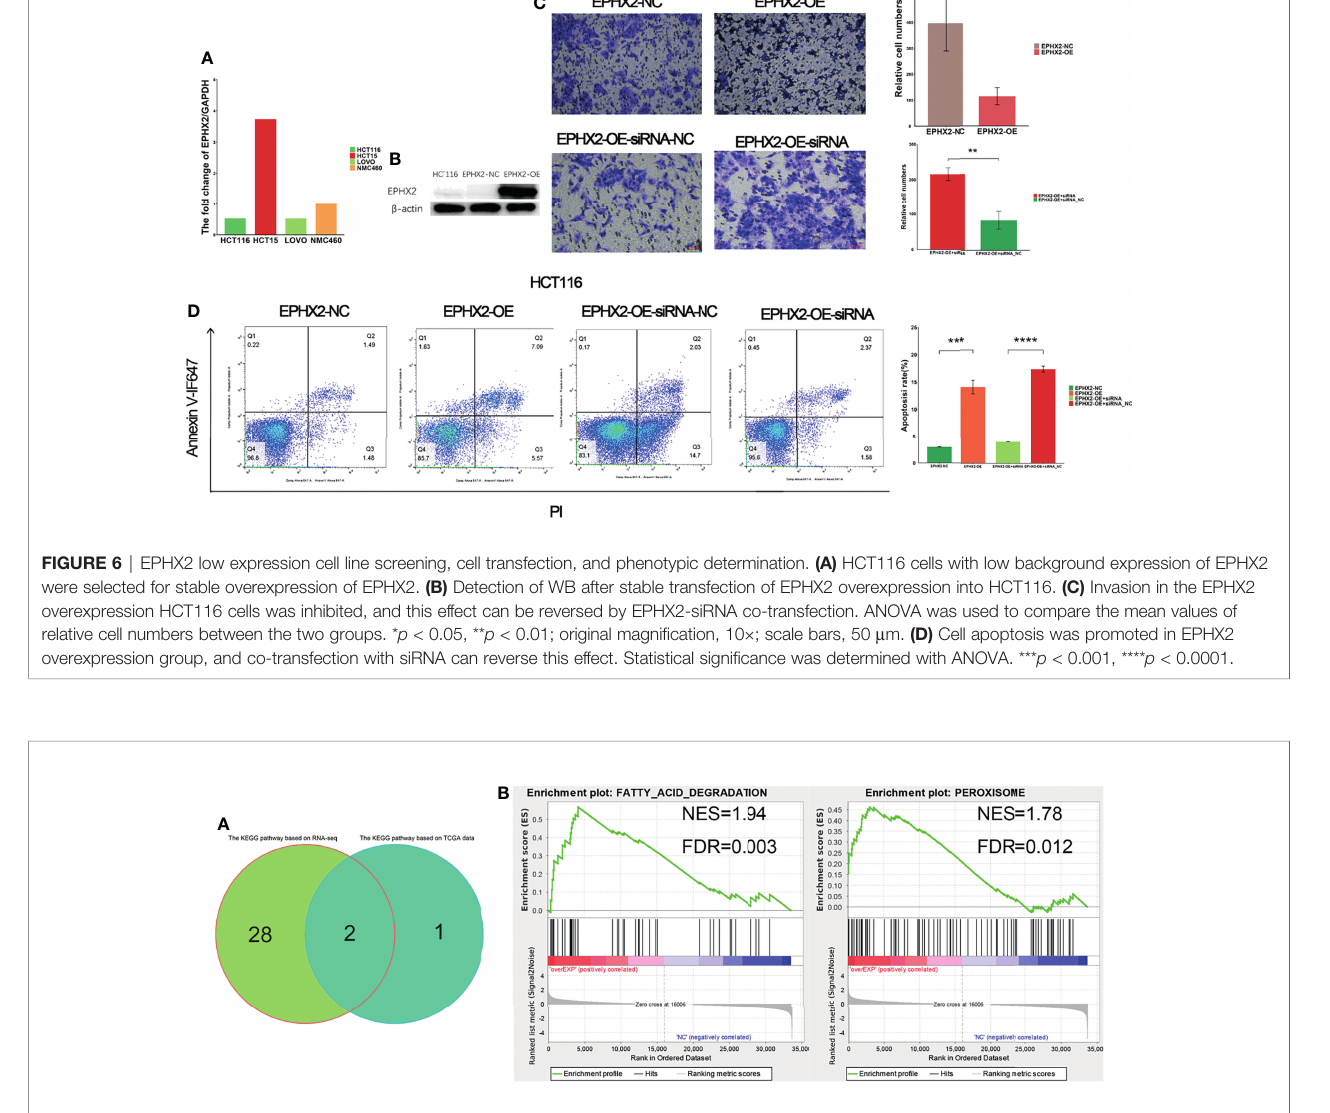
FIGURE 7 | RNA-seq analysis of HCT116 cells stably transfected with EPHX2 overexpression. (A) Venn diagram ofoptimal enrichment KEGG pathway. (B) Finally, fatty acid degradation and peroxisome were labeled as EPHX2 as the core genes of the target gene set to inhibit the KEGG signaling pathway in the progression of CRC. The fi gure shows the results of cell RNA sequencing GSEA enrichment analysis after visualization using the ggplot2 R